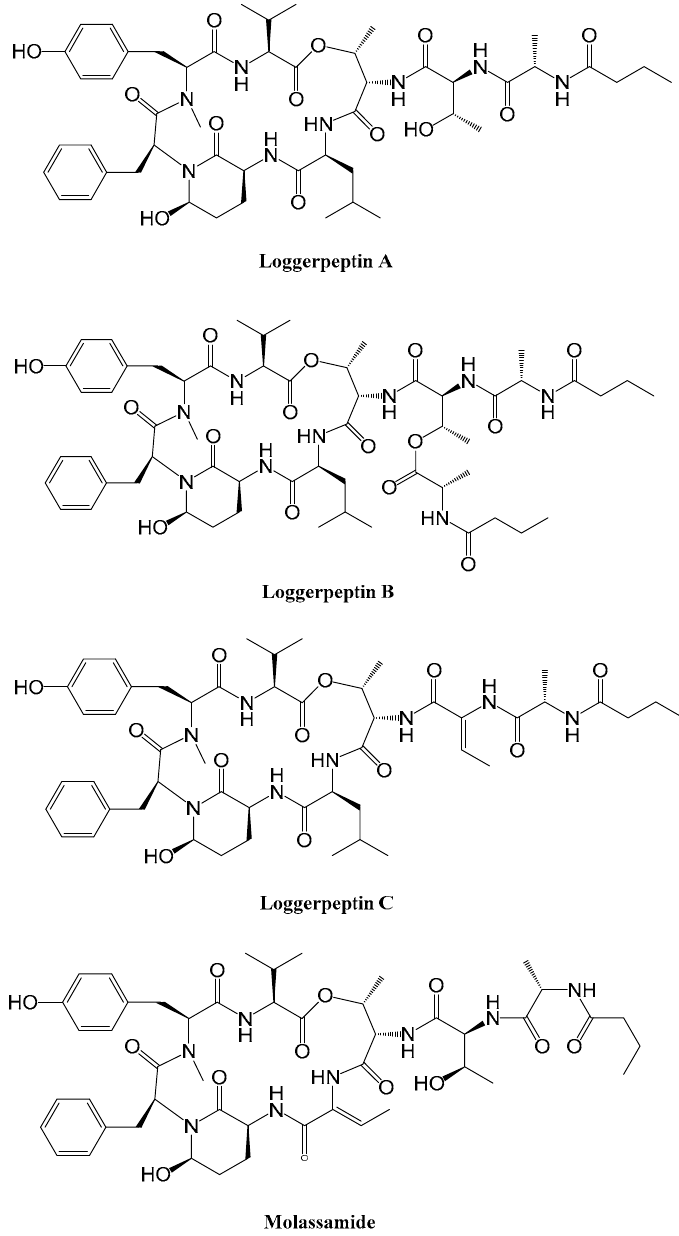
Figure 6. Structures of Loggerpeptins A–C and Molassamide.